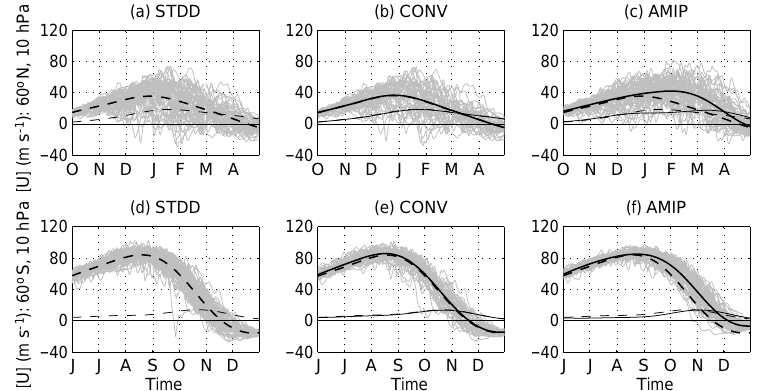
Figure 3. Daily time series of the zonal mean zonal wind [ U ] at 10hPa (gray solid lines): (a–c) 60 ◦ N and (d–f) 60 ◦ S. The square brackets denote the zonal mean. Panels (a, d) are for STDD, (b, e) for CONV, and (e, f) for AMIP. The climatological seasonal cycle and standard deviation of interannual variability for each day are denoted by black broken lines in (a, c) and by black solid lines in the other panels. Broken lines in (b, c, e, f) denote the results from STDD. The STDD data after the 1972–1973 season are used in (b, e) . Month labels are placed at the 1st day of each